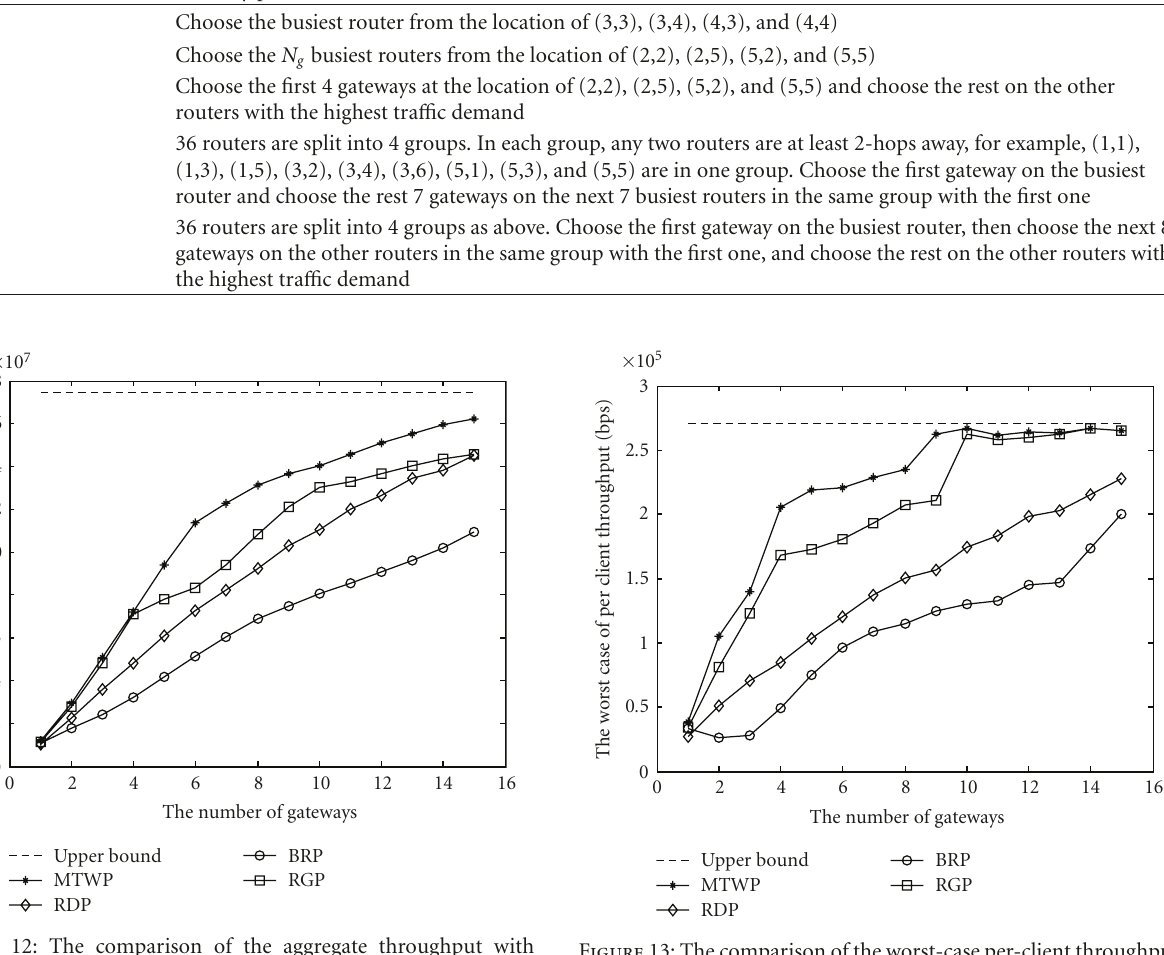
Figure 13: The comparison of the worst-case per-client throughput with unevenly distributed mesh